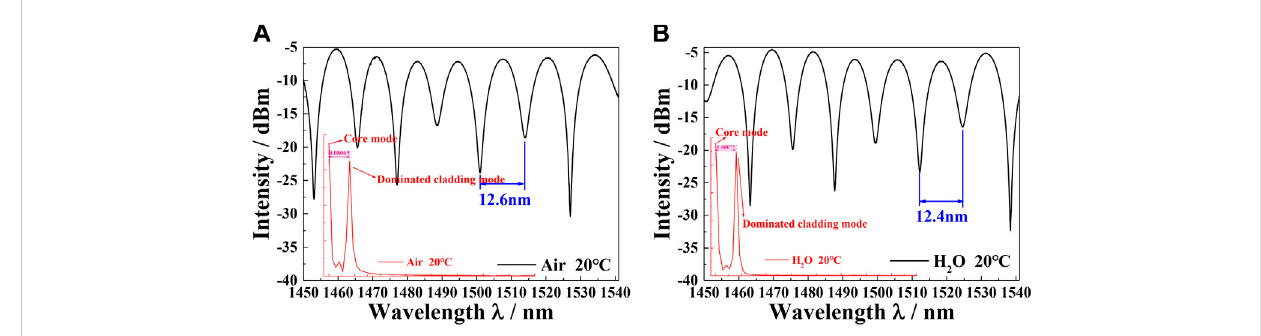
Interference-pattern analysis: the measured transmission spectrum and corresponding spatial frequency of the EMCF-based MZI in (A) air/ (B)